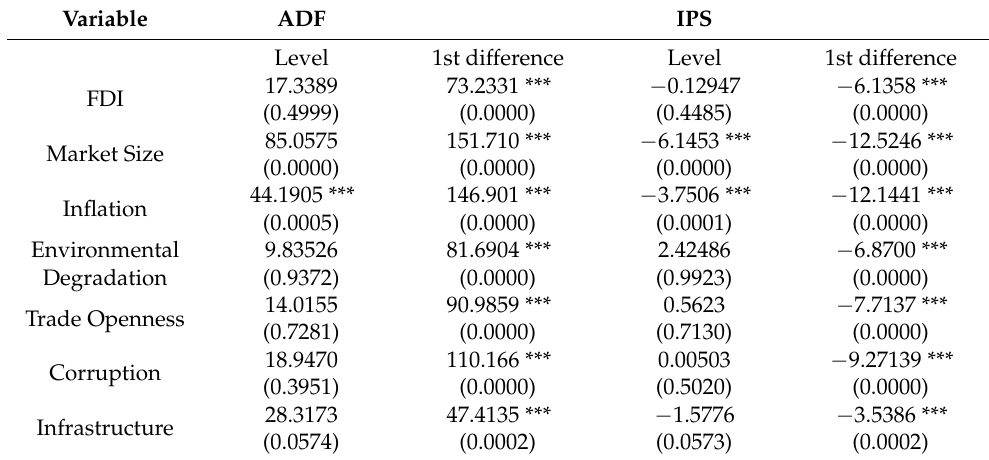
Table 4. Panel Unit Root Test Results.